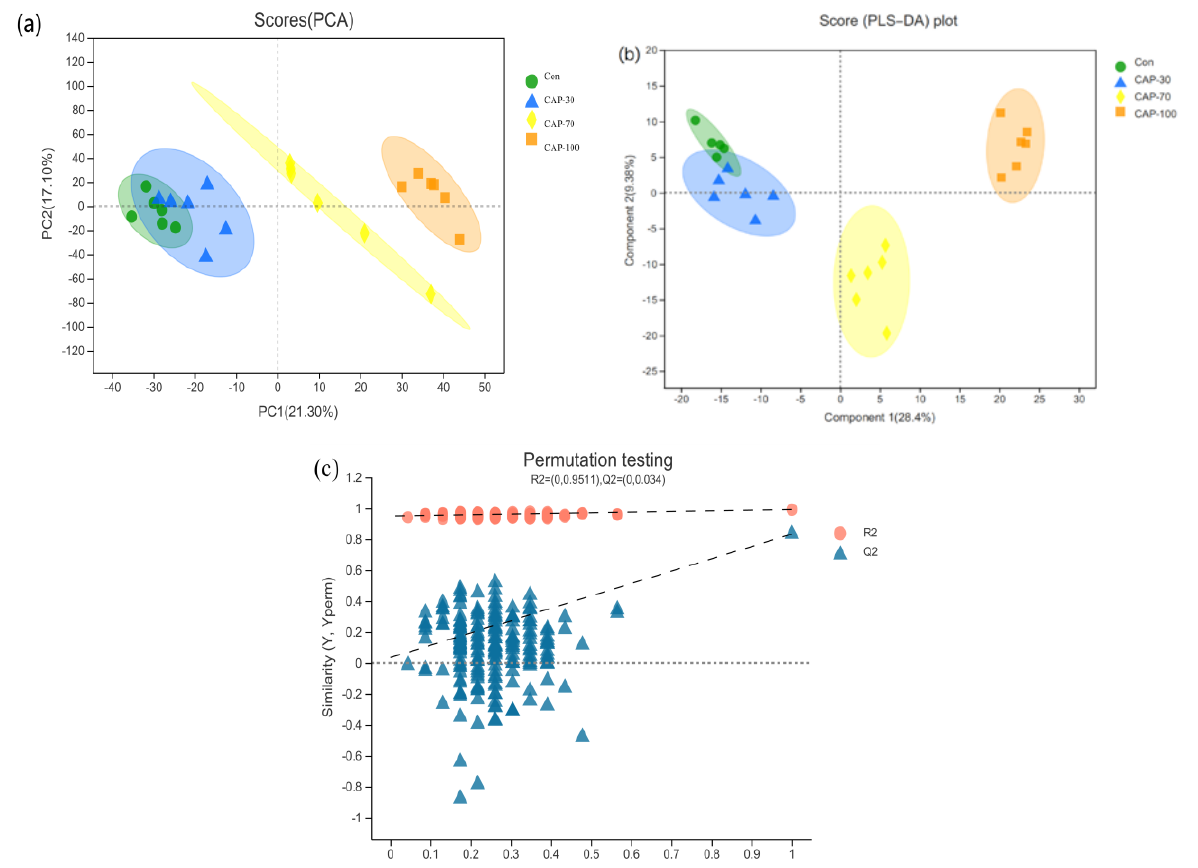
Figure 4. PCA score plots and PLS–DA score plots of muscle metabolomics. ( a ) PCA score plots of muscle metabolomics; ( b ) PLS–DA score plots of ESI+ mode and ESI − mode; ( c ) internal validation of PLS–DA score plots.